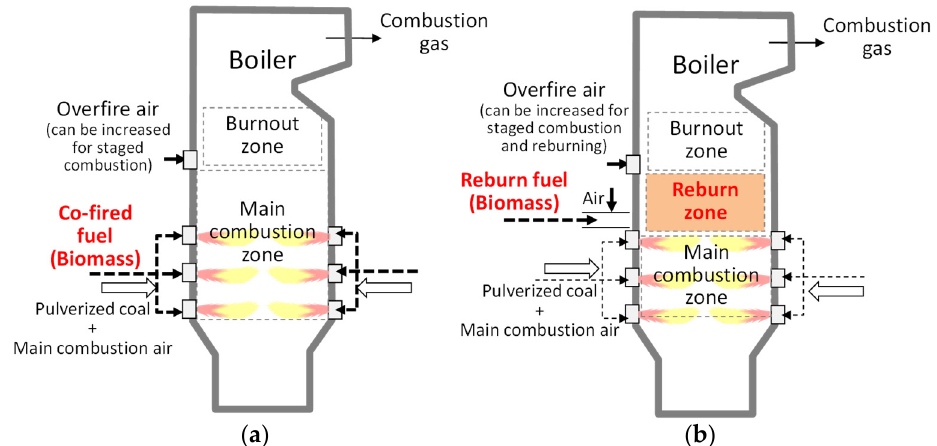
Figure 1. Conceptual diagram of the biomass cofiring and reburning in a pulverized coal boiler: ( a ) biomass cofiring; ( b ) biomass reburning.